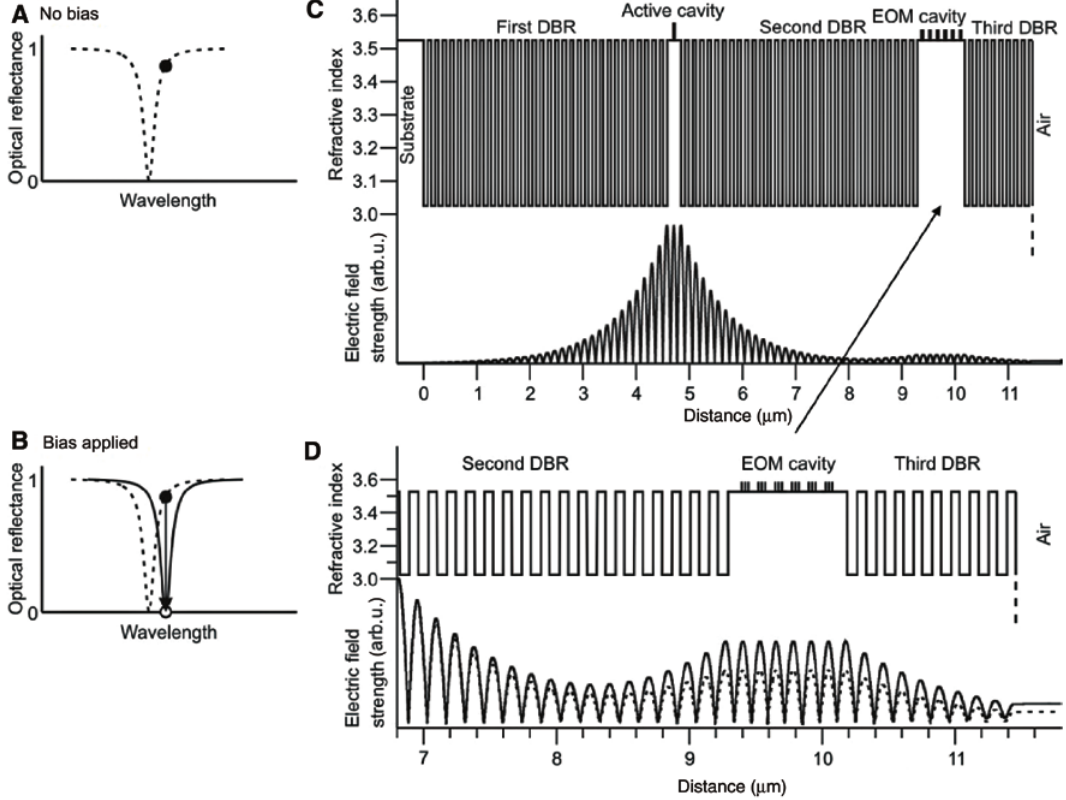
Figure 2: EOM VCSEL based on resonantly coupled cavities. (A) Optical power reflectance spectrum of the modulator cavity. Open circle corresponds to the lasing wavelength. (B) Upon an applied bias, the modulator reflectivity dip matches the lasing wavelength, increasing the light output power. Dashed line, cavity out of reso- nance; solid line, cavity in resonance. (C) Profiles of the refractive index and electric field strength in the VCSEL optical mode. (D) Top part of the device: profiles of the refractive index and electric field strength in the VCSEL mode in the open state (solid line) and closed state (dashed